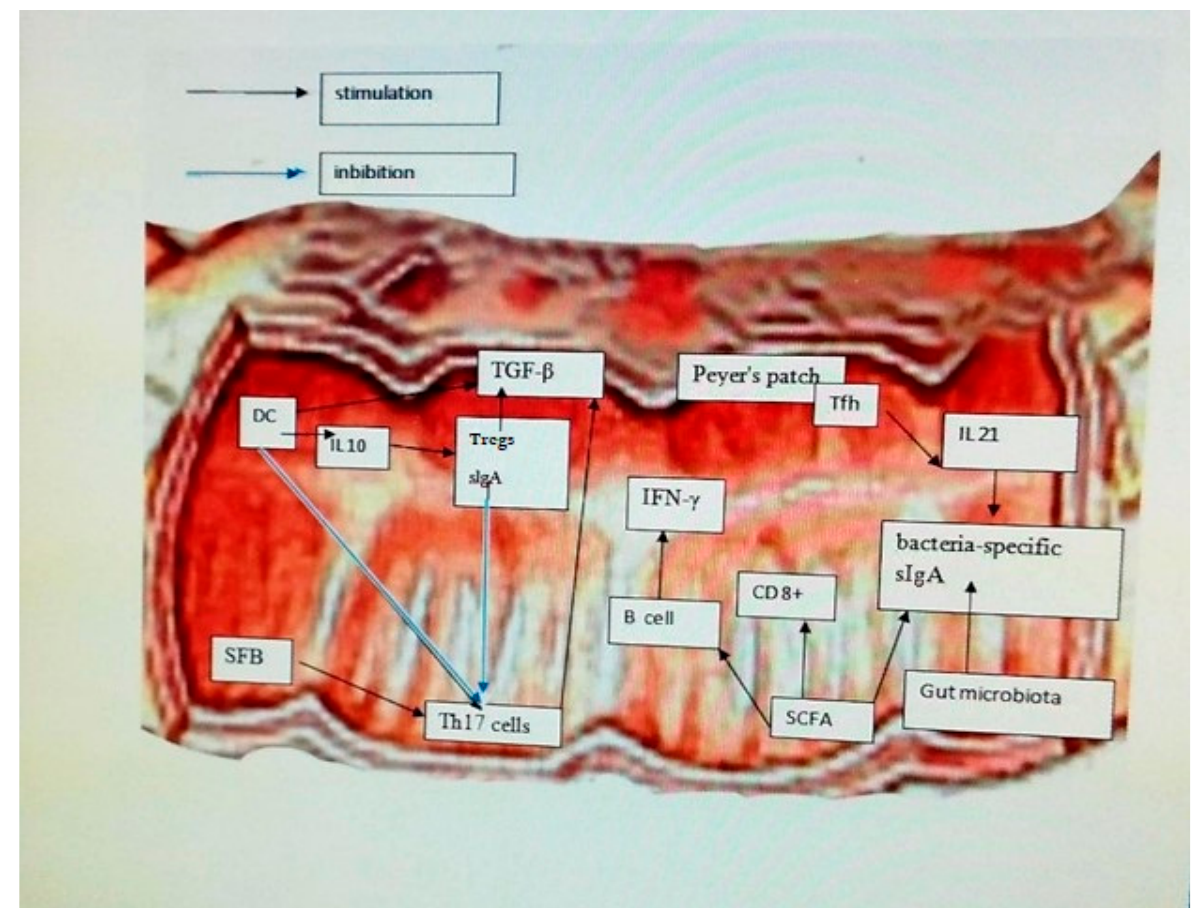
Figure 2. Effect of the modulatory role of intestinal microbiota and interactions between immune cells. Dendritic cells (DC) respond to microbes by secreting cytokines that trigger inflammation and stimulate the adaptive immune response by producing Tregs and sIgA by secreting IL-10. Parts of bacteria such as short-chain fatty acids (SCFA) induce T lymphocytes and B lymphocytes to produce gamma interferon (IFN- γ ) from CD8+ T cells. Microbiota, SCFA, and IL-21 secreted from T follicular helper cells (Tfh) in Peyer’s patches (PP) contribute to the secretion of bacteria-specific sIgA. Sequestered fragments of bacteria (SFB) induce the production of Th17 cells. Tregs modulate the anti-inflammatory action of Transforming Growth Factor- β (TGF- β )-mediated DC and T helper 17 cells (Th17) e. DC and sIgA negatively regulate the pro-inflammatory function of Th17 cells by down-regulating synthesis 17 (IL17).